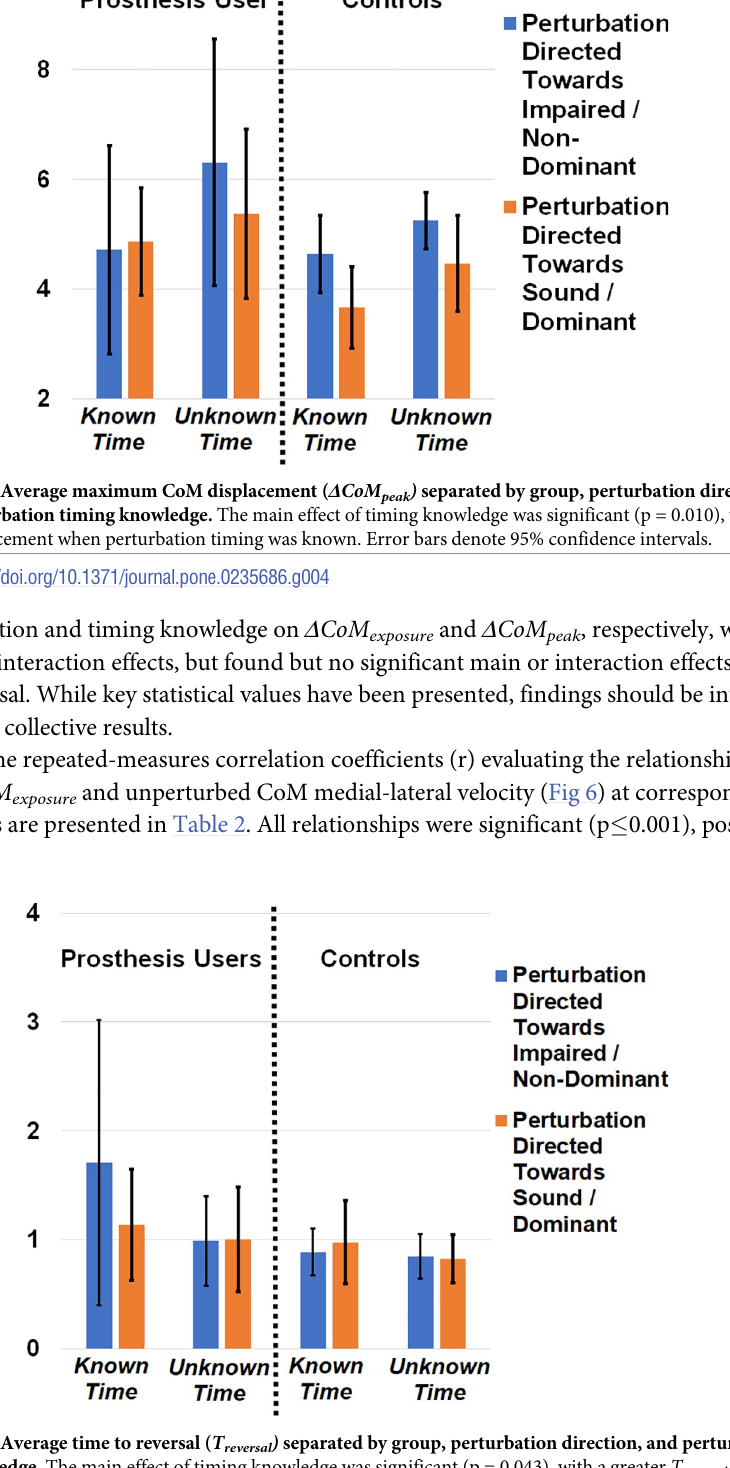
when perturbation reversal